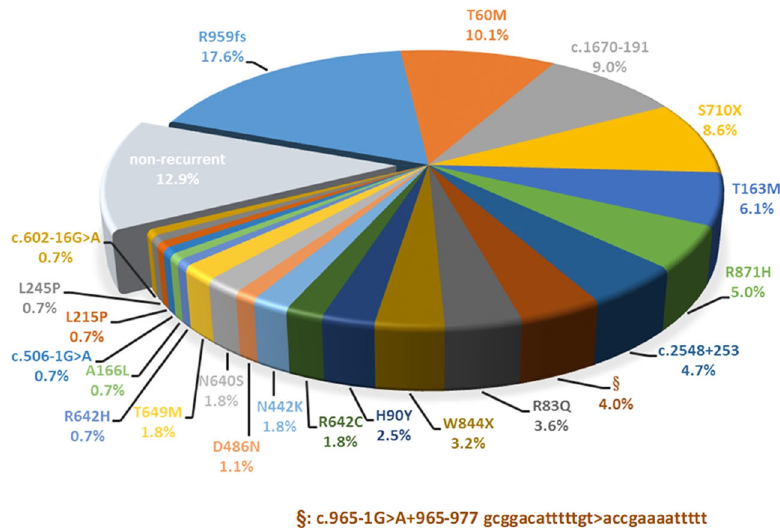
Fig. 2 Twenty-two recurrent mutations with different percentage of all 57 SLC12A3 mutations. Twenty two recurrent mutations comprise 87.1% of all allelic mutations, compared with 35 non-recurrent mutations responsible for only 12.9% of all allelic